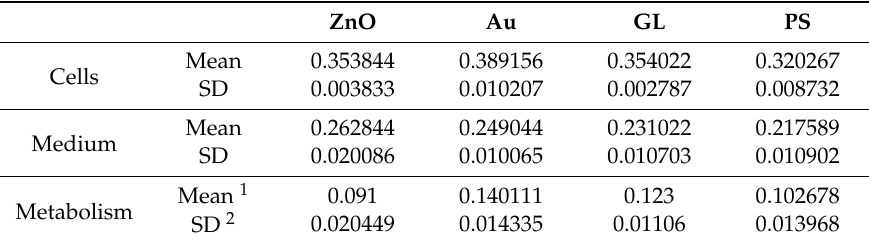
Figure 5. MTT assay of cardiomyocytes showed the absorbance of material + cardiomyocytes and material + medium, and the absorbance for the metabolism of cardiomyocytes (data were presented as mean + standard deviation; standard deviation was shown as the plus direction of the error bar; * represented a significant difference compared to the absorbance of cell culture-treated polystyrene multi-well culture plates (PS) + medium; Λ and ∴ represented a significant decrease or increase compared to the metabolism levels of the cells cultured on Au-coated cover glasses (Au) and PS, respectively). Table 5. The absorbance of the MTT assay of cardiomyocytes.